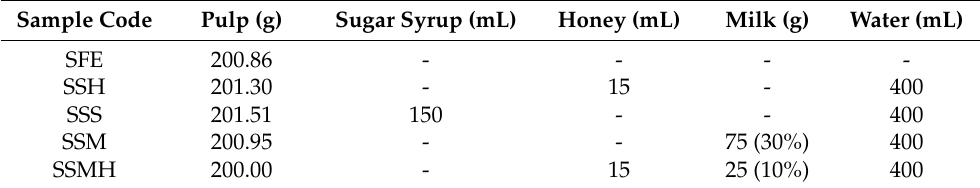
Table 1. Raw materials and quantities used in the formulation of the soursop